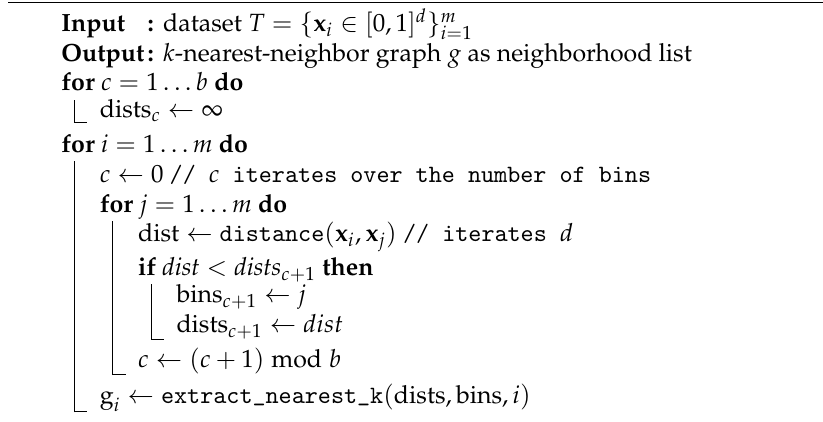
Algorithm 3: A variant of the O ( m 2 ) k -nearest-neighbor algorithm that uses b